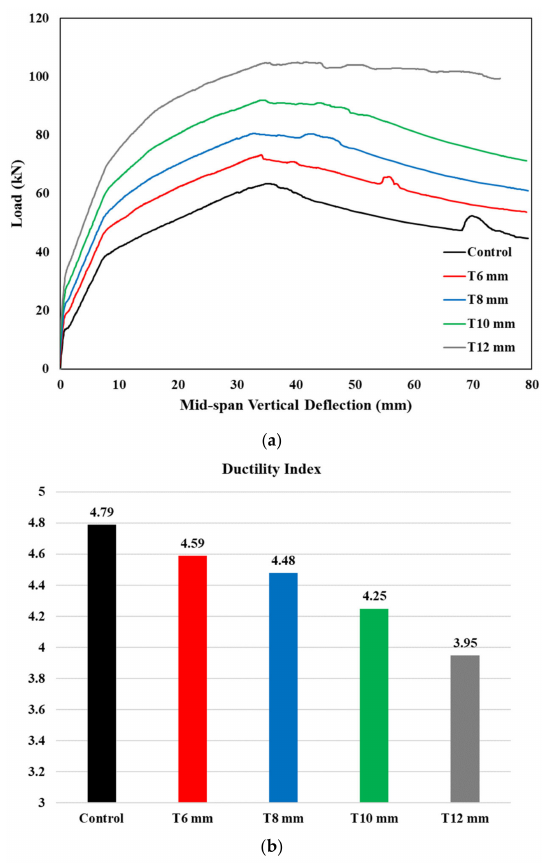
Figure 14. Effect of varying Fe-SMA bar diameter on ( a ) load-deflection behavior and ( b ) ductility